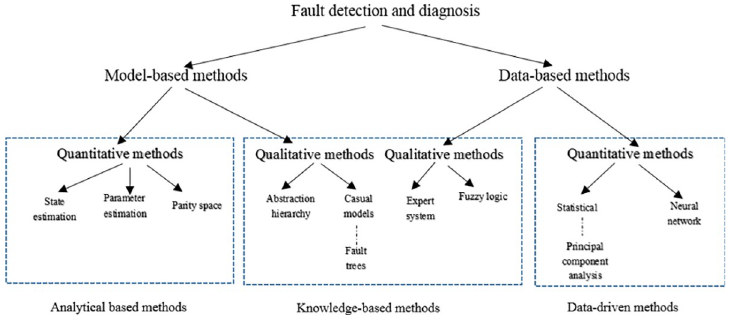
Fig 1. Classification of fault detection and diagnosis method